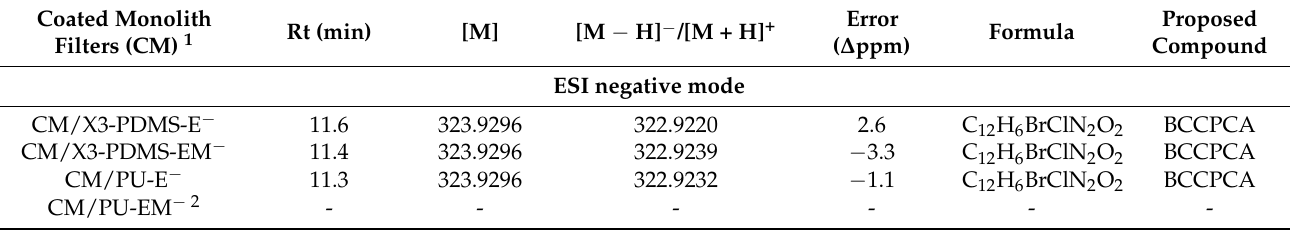
Table 2. Identification of a leached compound from monoliths coated with polydimethylsiloxane (X3-PDMS) and polyurethane (PU) coatings containing incorporated (X3-PDMS-E and PU-E) and grafted Econea (X3-PDMS-EM and PU-EM), by UHPLC-MS/MS in negative ([M − H] − ) and positive ([M + H] + ) ESI modes. The compound was identified by the retention time (Rt).